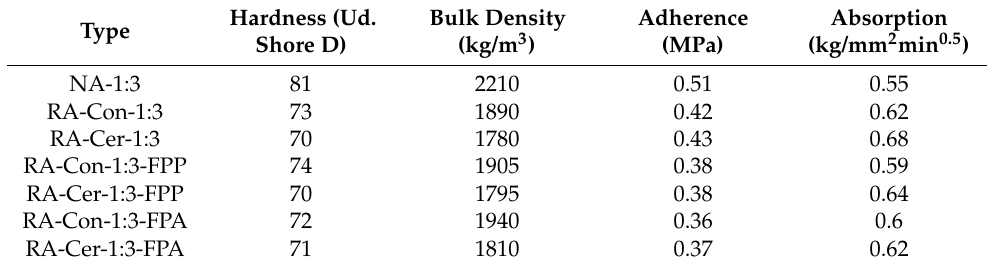
Table 13. Physical properties of processed